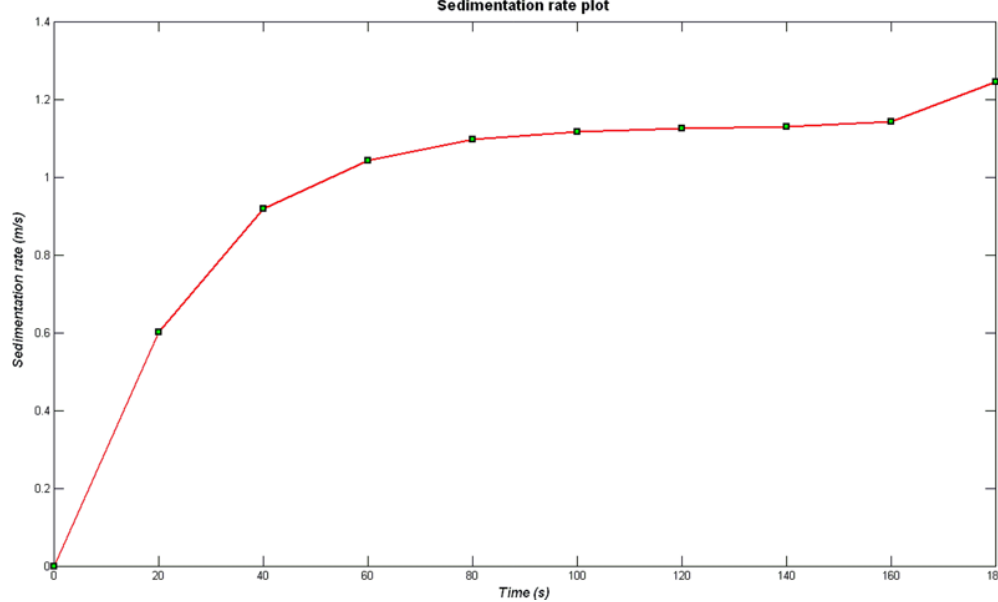
Fig. 3. Sedimentation rate in the PDC as a function of time at 500m from the vent.